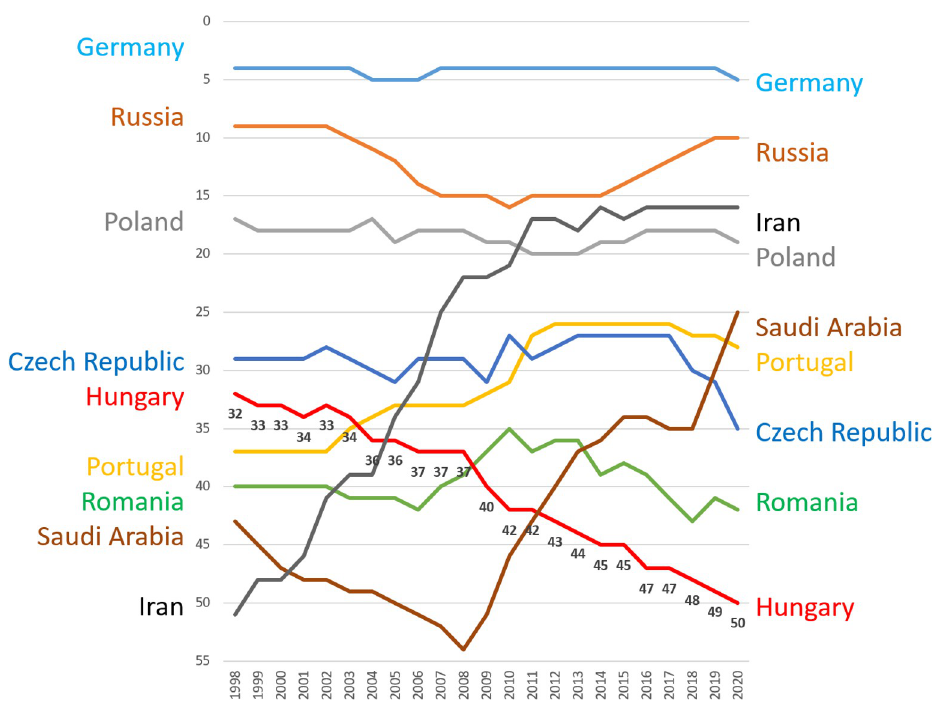
Fig 1. Selected countries in the SCImago country rank index compared to Hungary. While most Eastern European countries were able to maintain their overall ranking, Hungary consistently reached lower scores in the last twenty years. Some countries were able to achieve significant